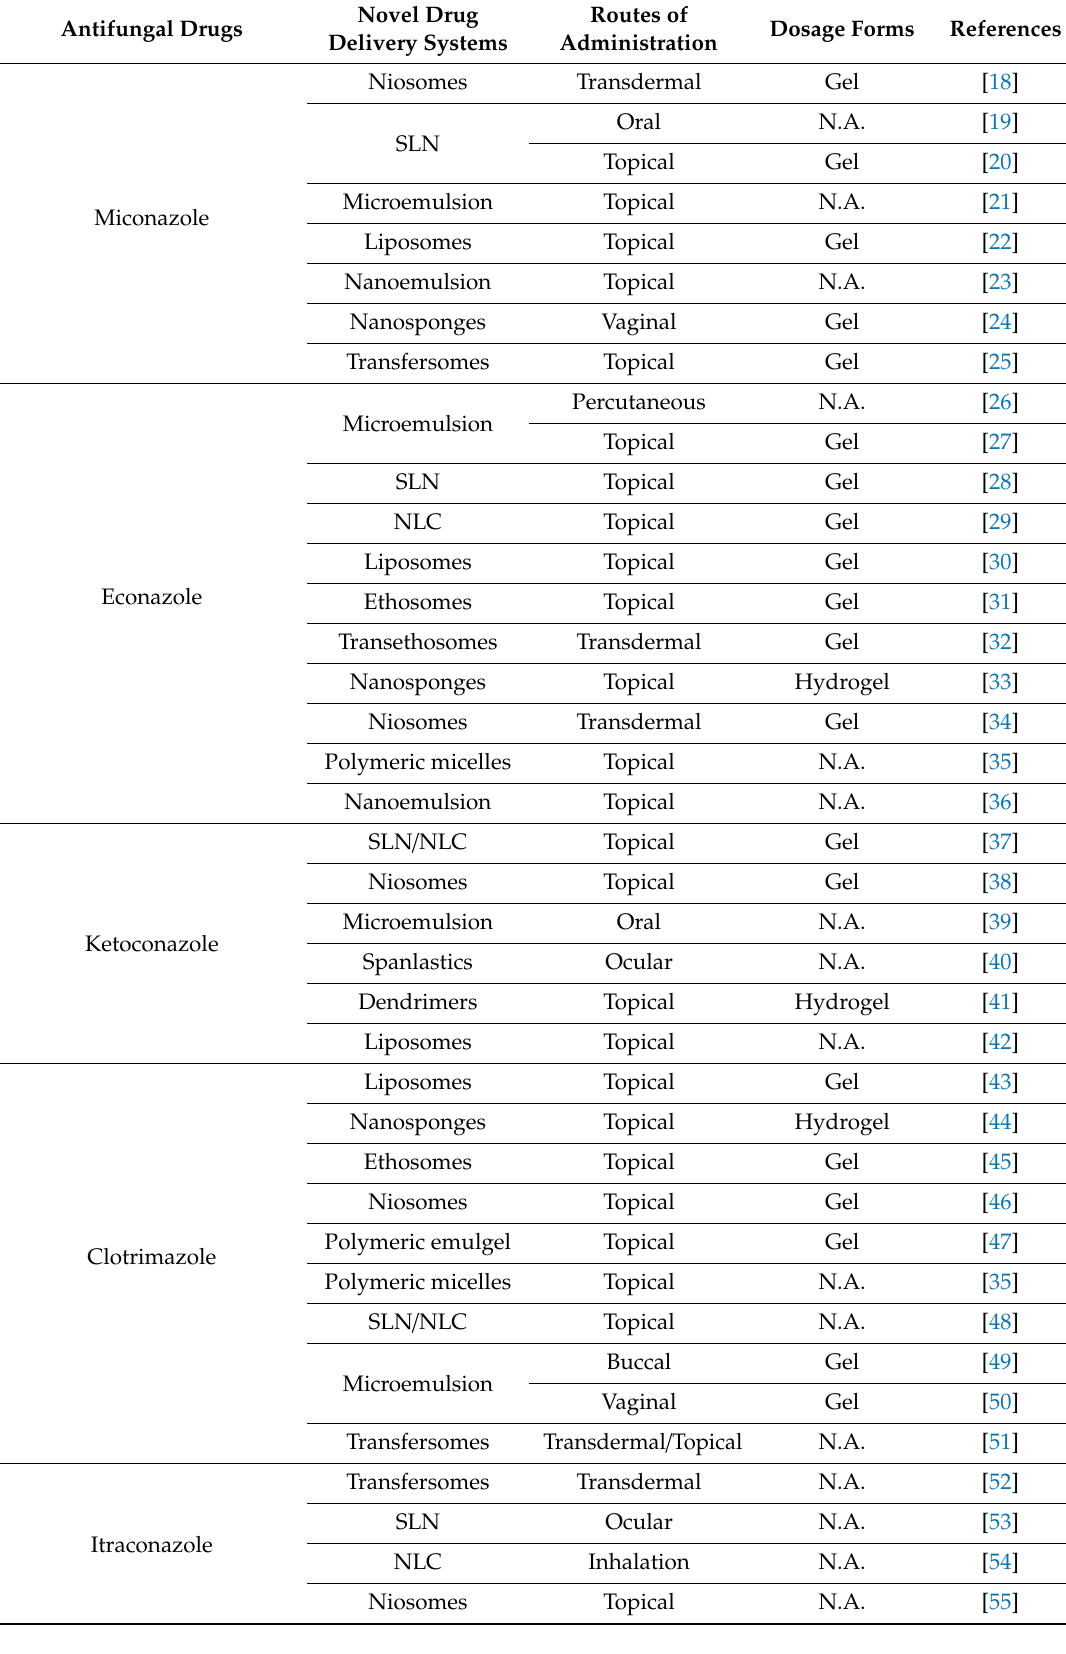
Table 2. Some of the novel drug delivery systems already developed for each antifungal